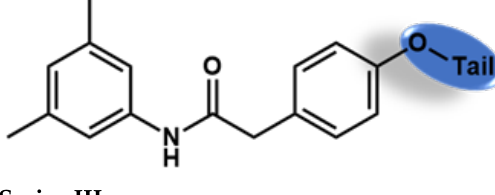
Red blood cell analyses were carried out at a final effector concentration of 2 mM. All stock solutions were prepared in DMSO at a concentration of 200 mM. P 50 represents the partial pressure of oxygen when 50% hemoglobin is saturated in the presence of effectors. P 50 C is the control value of P 50 in the presence of 1% DMSO. ∆P 50 = (P 50 – P 50 C) in mmHg. K is the Hill coefficient of the oxygen dissociation curve when the red blood cells are 50% saturated. Data are displayed as mean ± SD.